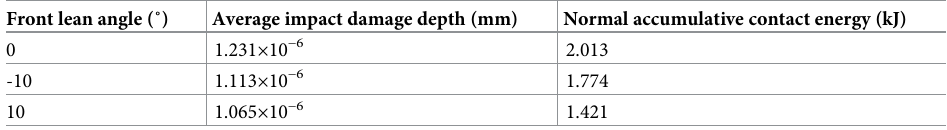
Table 7. Simulation results of the impact damage to the middle plate under the different front lean